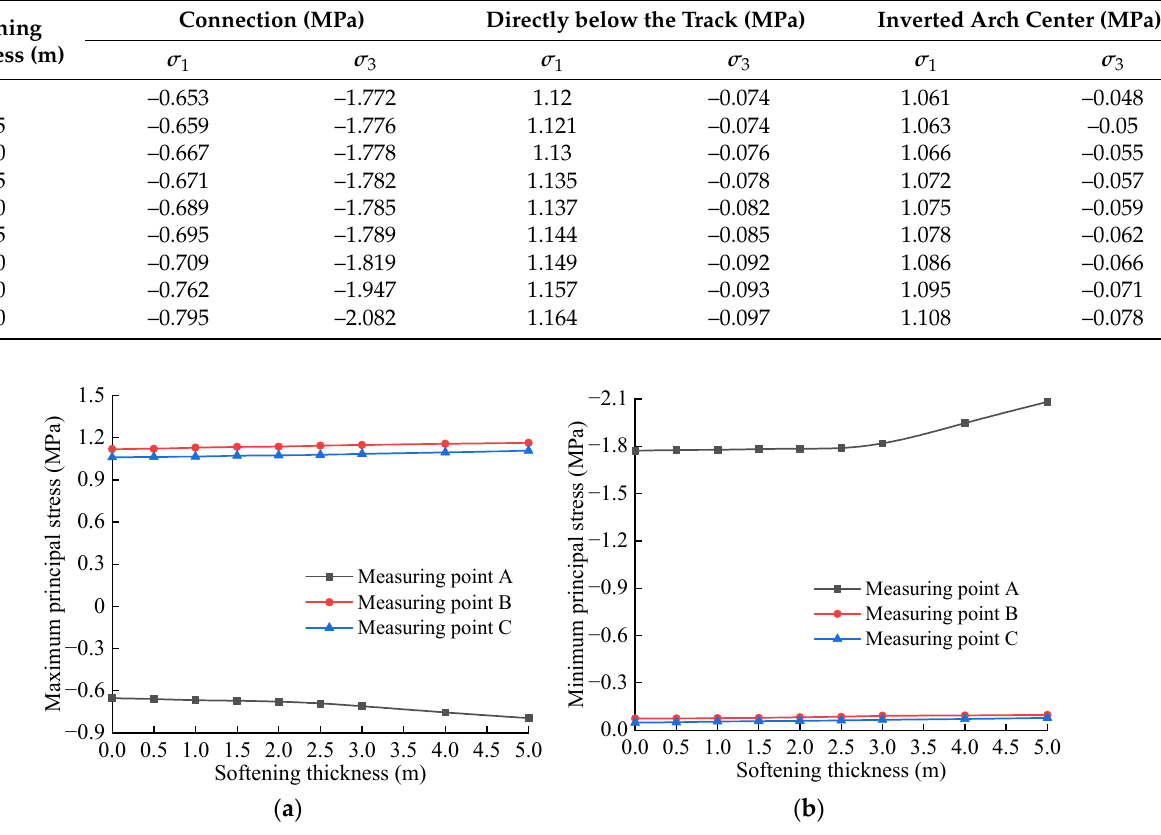
Figure 15. Variation curve of principal stress of base structure with different softening thickness: ( a ) Maximum principal stress; ( b ) Minimum principal stress.